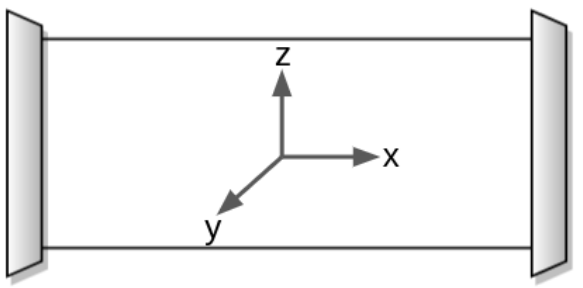
Figure 30. Orientation of the accelerometer inside the